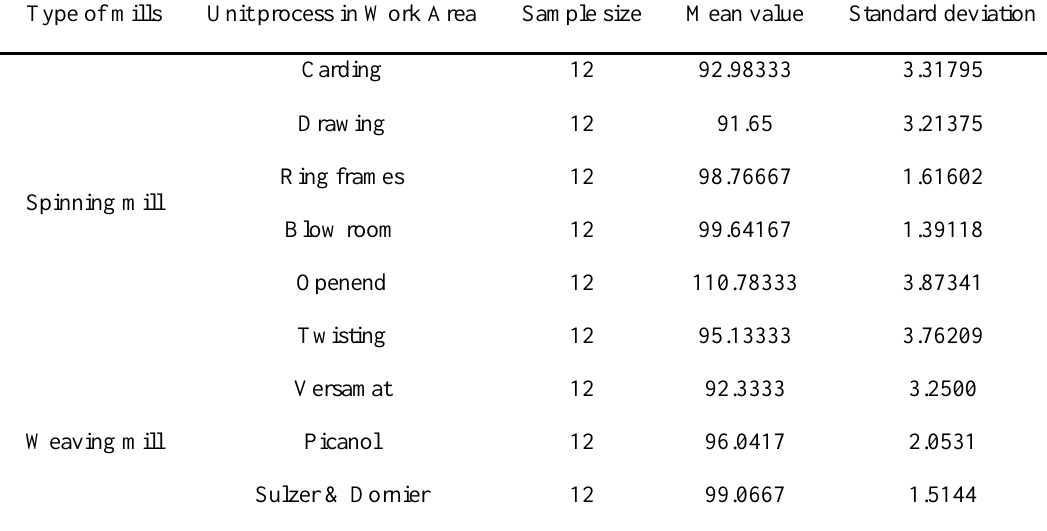
Table 2. Noise pressure levels (LAeq) for spinning and weaving mills at the 12 measuring points (data are reported as means ± standard